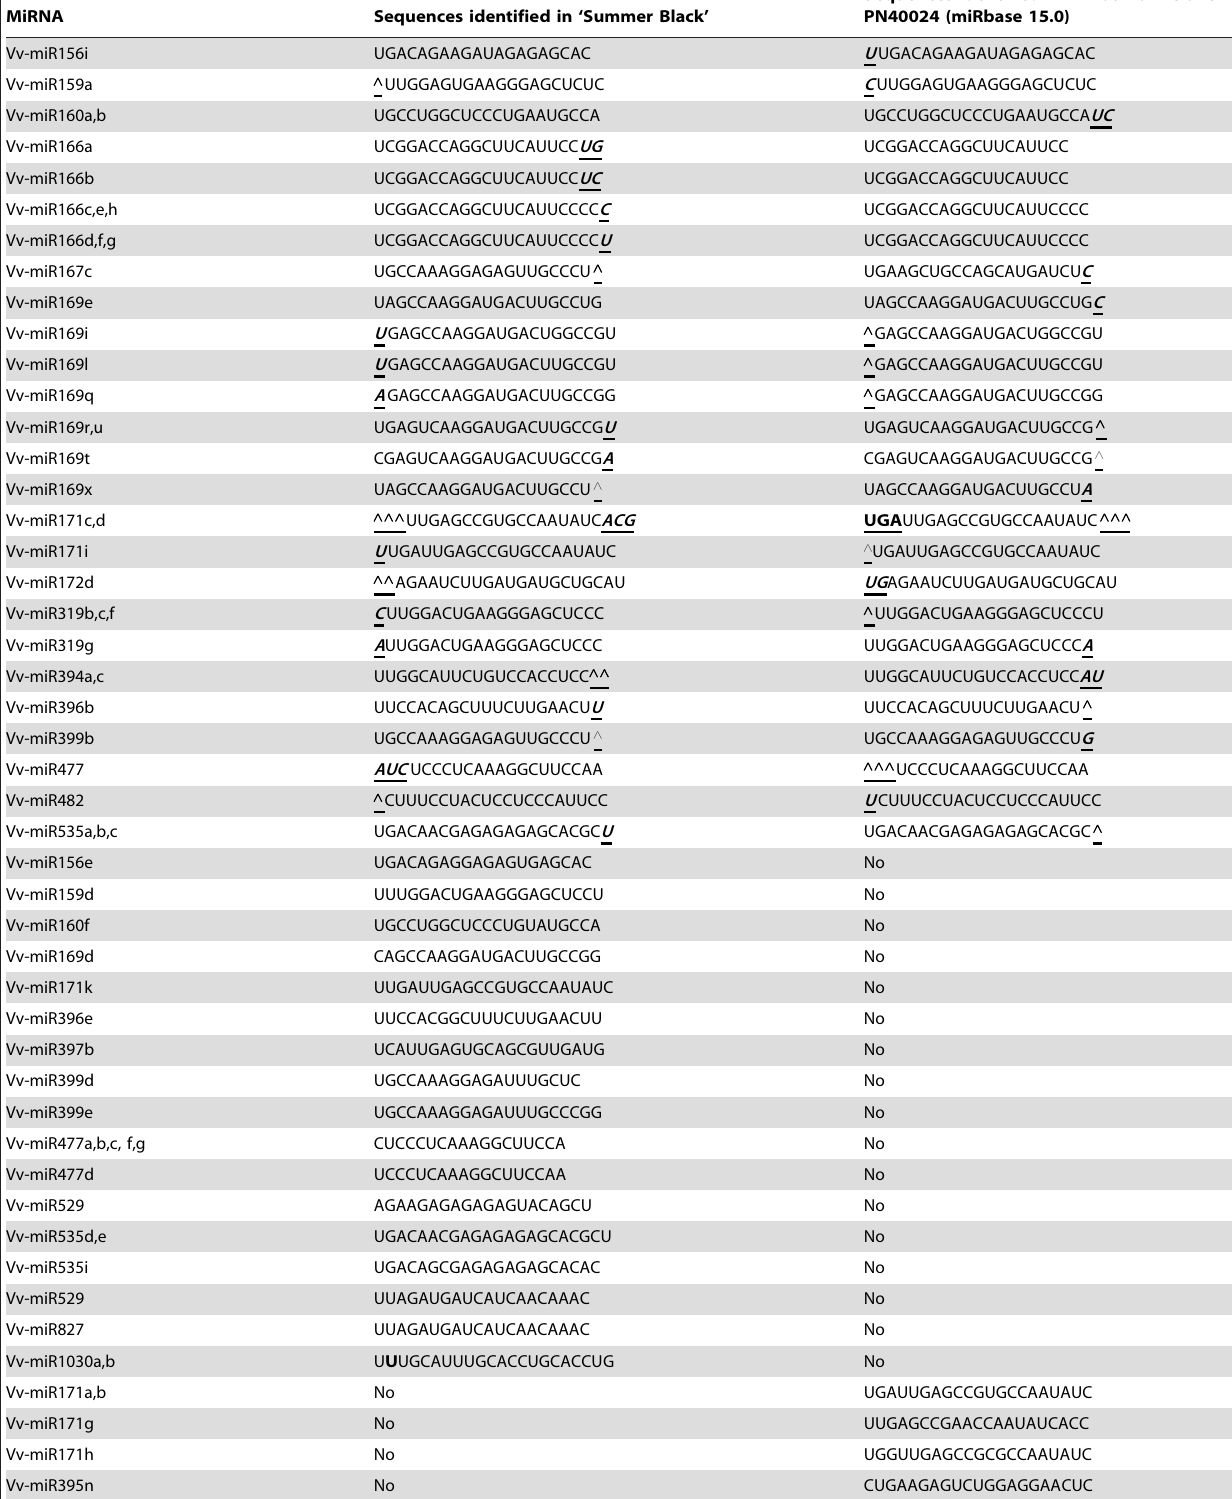
MiRNA Sequences identified in ‘Summer